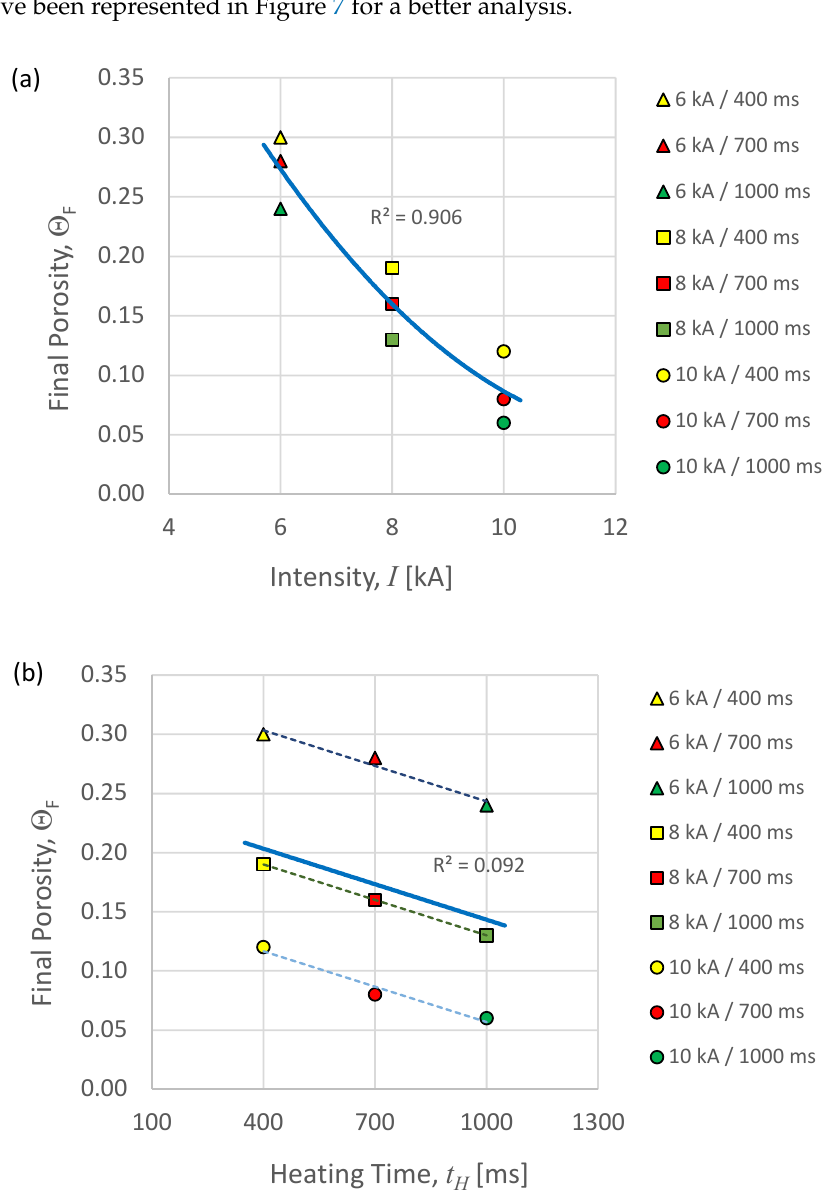
Table 1. Values of the compacts final porosity ( Θ F ) in function of the intensity (in kA) and heating time (in ms) for the different MF-ERS experiments. Heating Time 400 ms 700 ms 1000 ms 6 kA 0.30 0.28 0.24 Intensity 8 kA 0.19 0.16 0.13 10 kA 0.12 0.08 0.06 Metals 2018 , 8 , x 8 of 14 Porosities in Table 1 follow a reasonable trend, with the lower value for the bottom right cell. Data in Table 1 have been represented in Figure 7 for a better analysis.